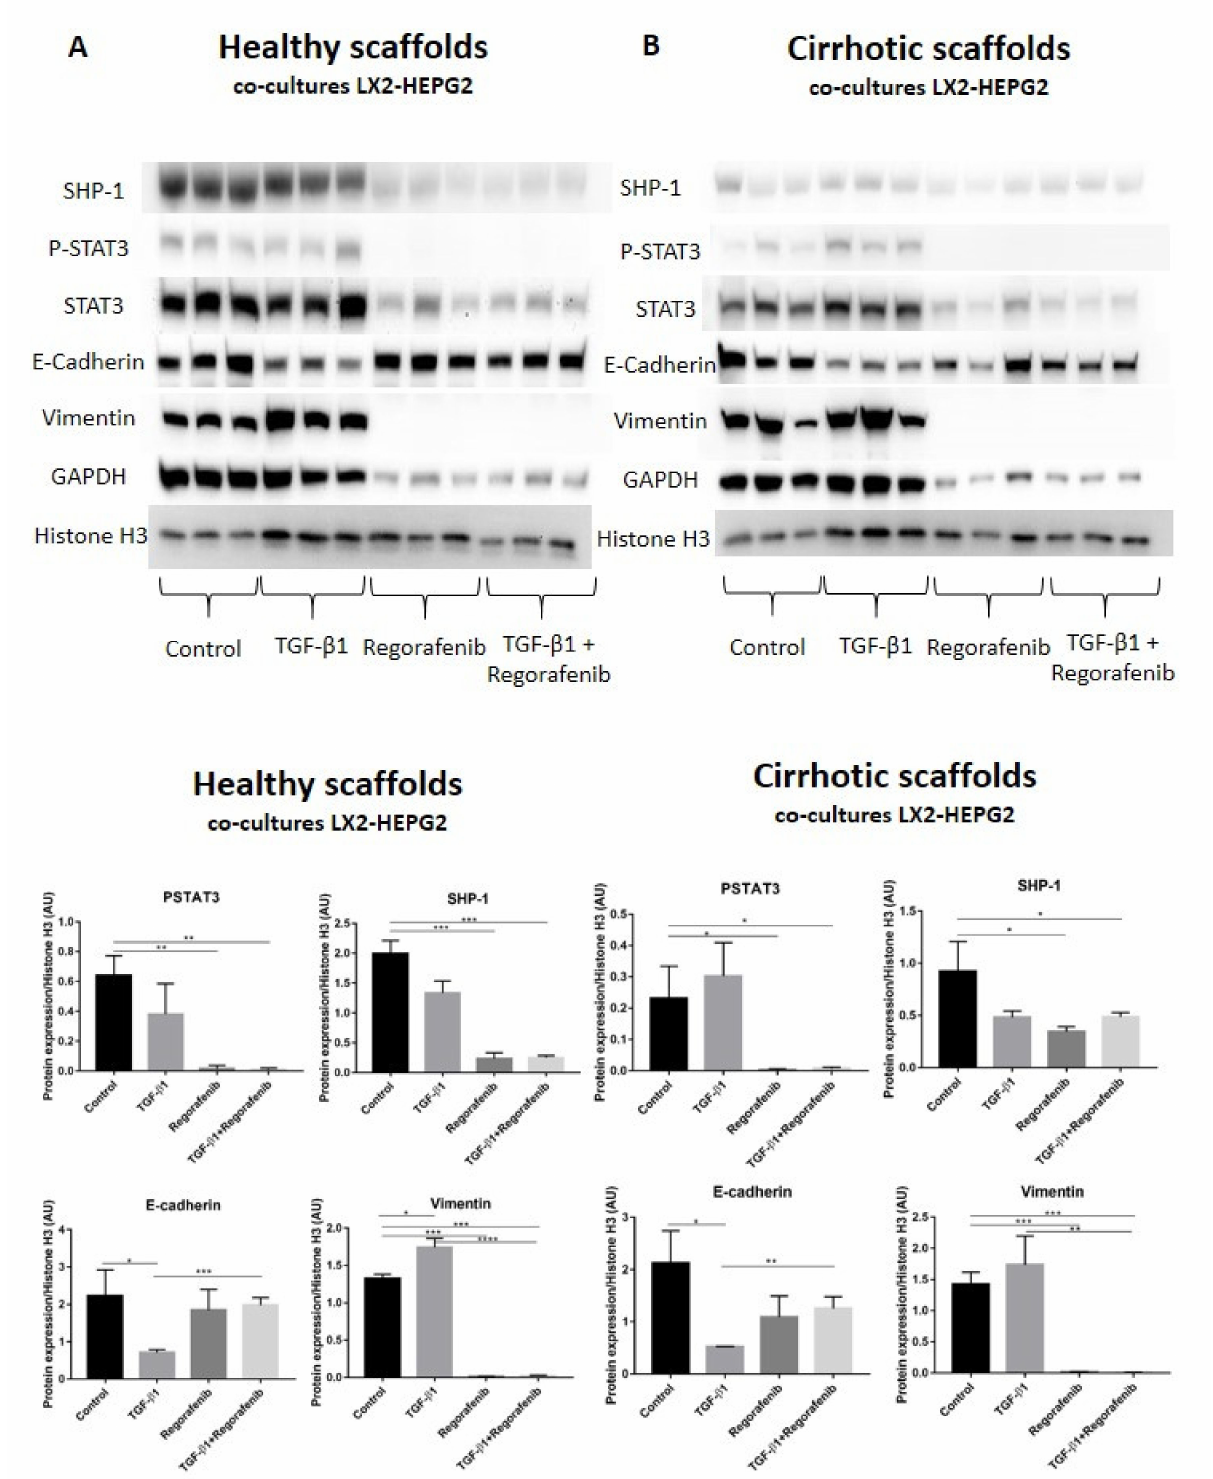
Figure 6. Protein expression of the LX2 and HepG2 cell co-cultures treated with TGF- β 1 and/or Regorafenib in healthy and cirrhotic liver 3D scaffolds. Western blot and densitometry analysis of SHP-1, P-STAT3, STAT3, E-cadherin, Vimentin, and GAPDH protein expression of LX2 and HepG2 cells co-cultured in 3D healthy ( A ) and cirrhotic scaffolds ( B ) following TGF- β 1 5 ng/mL with/without Regorafenib 16.6 µ M exposure for 6 days ( n = 4 scaffolds per condition, * p ≤ 0.05, ** p ≤ 0.01, *** p ≤ 0.001, and **** p ≤ 0.0001). (Figure S1: Whole blot showing all the bands with all molecular weight markers on the